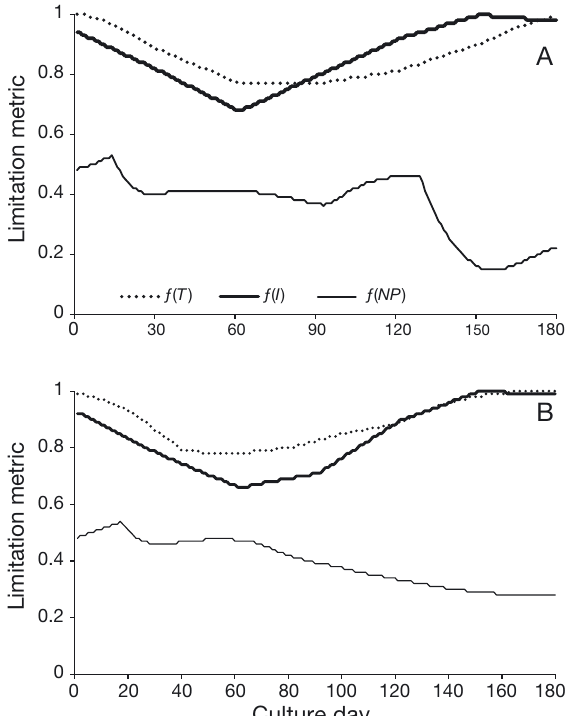
Fig. 6. Comparison among environmental limitation factors for temperature ( T) , irradiance ( I) and nutrients (dissolved inorganic nitrogen or phosphorus; NP) on the growth of cul- tured kelp Saccharina japonica . Results of normalized func- tions over time are shown; a value close to 1 indicates the absence of limitation. (A) 2011−2012, (B) 2008−2009